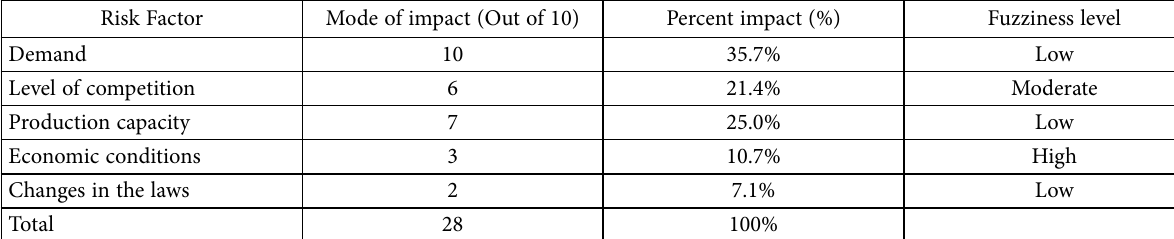
Table 1. Modes of risk factors’ impacts assessed by the respondents